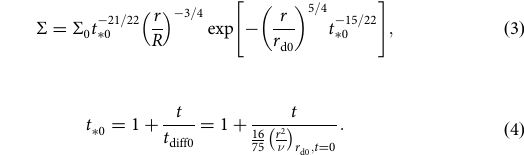
Fig. 4 Disk structure formed by an impact between rocky planets ( M T = 5 M ⊕ , γ = 0.13, θ = 48.5 ∘ , v imp = v esc , and Run ID6). All of these models have the same angular momenta and disk masses. The panels show ( a ) the surface density, ( b ) temperature, ( c ) vapor mass fraction, and ( d ) pressure gradient parameter η as a function of the radial distance from the planet r normalized by the Earth radius R ⊕ . The dotted line represents the direct outcome from the SPH simulation. The sky-blue line represents an exponential model and the green line represents a polynomial disk model. The planetary radius is 1.74 R